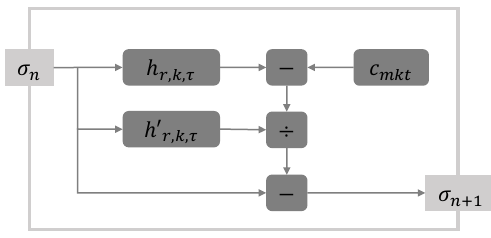
Figure 1. Newton–Raphson update